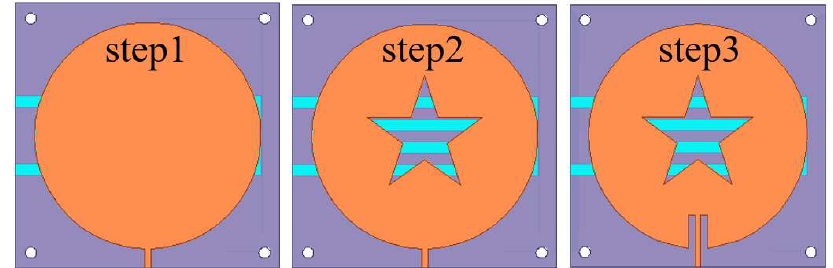
Figure 2. The evolution of the sensor patch slotting shape.